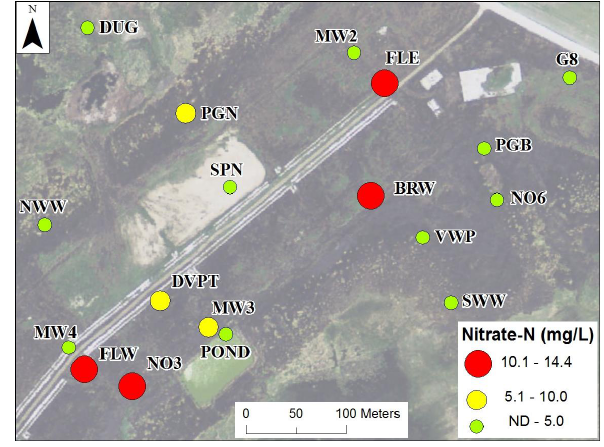
Figure 4. Nitrate-nitrogen concentrations (summer 2013). Fig. 4. Nitrate-nitrogen concentrations (summer